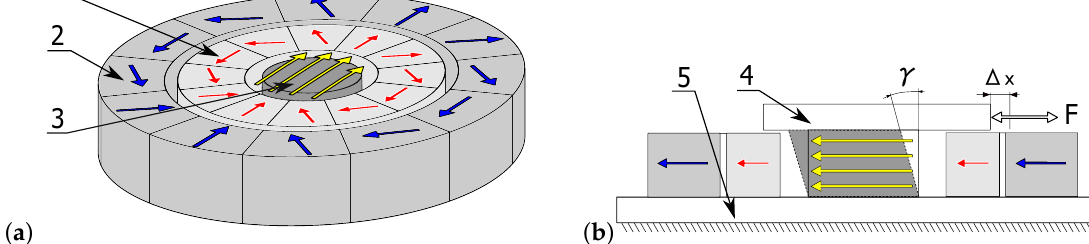
Figure 1. Scheme of magnetorheological elastomer sample placed inside the Halbach matrix: ( a ) view of an array with the sample; and ( b ) cross-section. Notation is presented in the text.